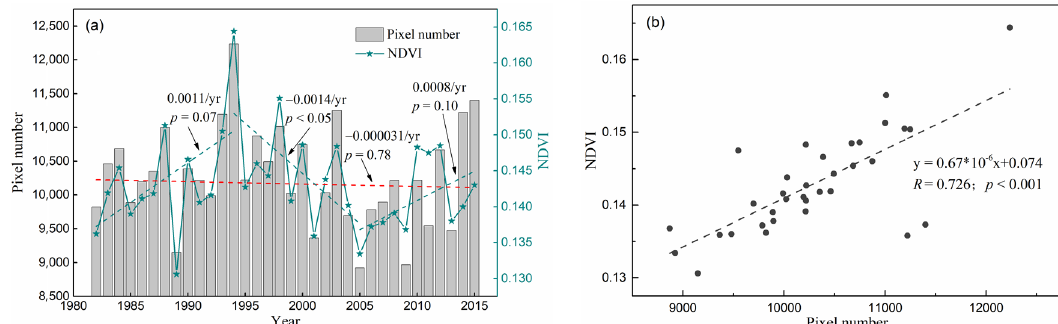
Figure 2. Interannual changes in spatial average NDVI and number of grids with NDVI ≥ 0.1 ( a ) and regression relationship between NDVI and number of pixels with NDVI ≥ 0.1 ( b ) of the growing season in ASTZMP during 1982–2015.